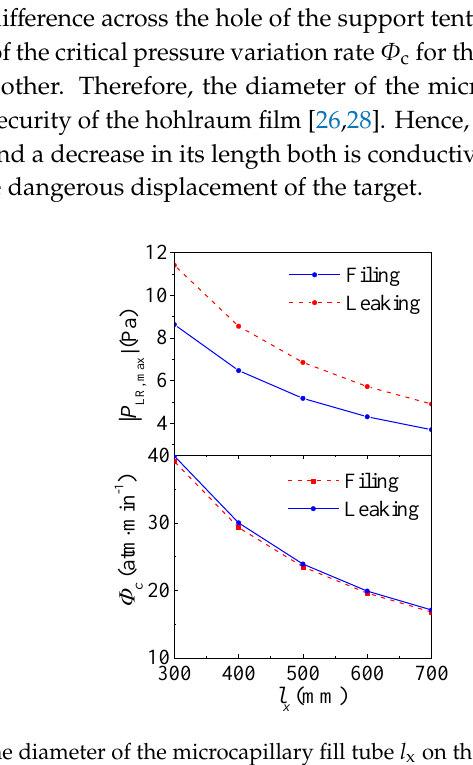
= 0.2 mm, LR, max . ( d o